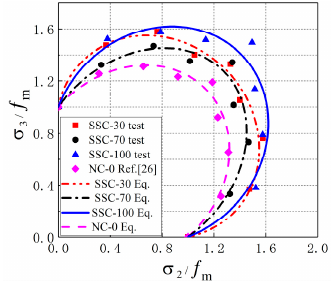
Figure 9. Biaxial C–C failure criterion model of SSC.